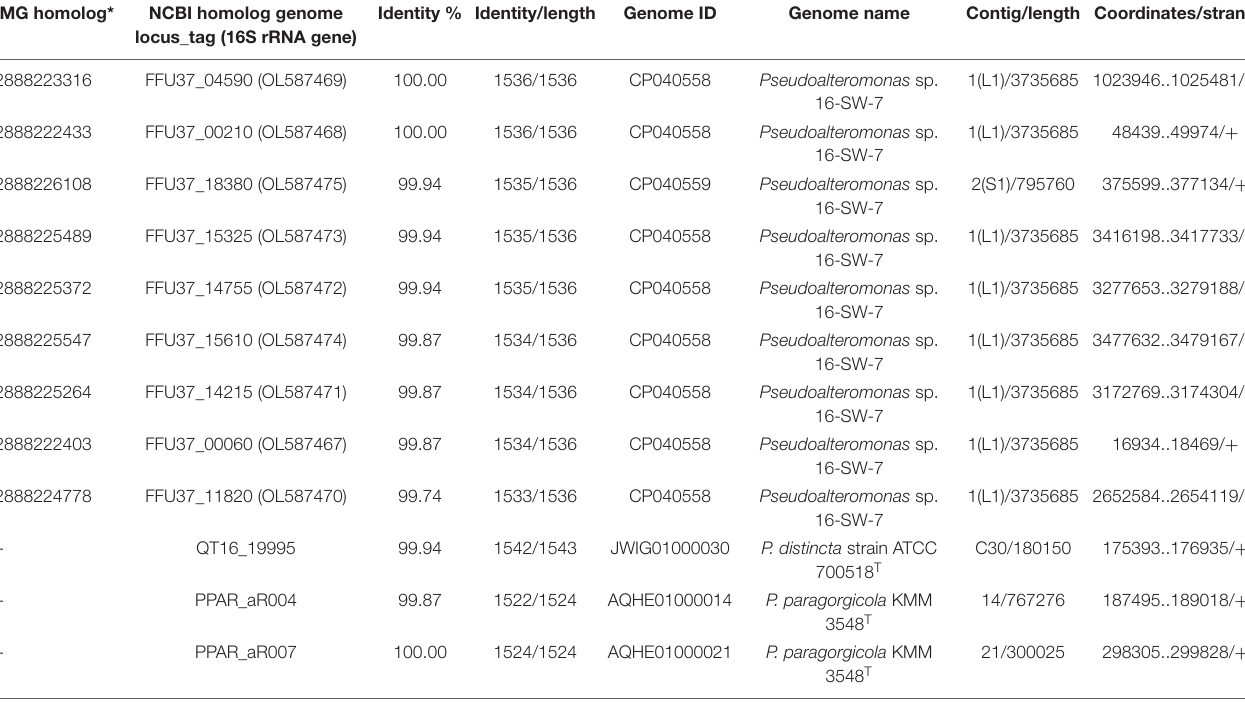
TABLE 3 | The 16S rRNA gene sequences content and similarity for the strains Pseudoalteromonas sp. 16-SW-7, P. distincta ATCC 700518 T , and P. paragorgicola KMM 3548 T . IMG homolog* NCBI homolog genome Identity % Identity/length locus_tag (16S rRNA gene)